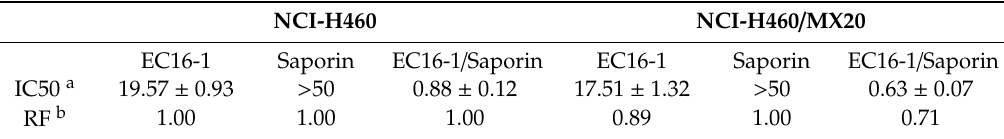
Table 2. E ff ect of EC16-1 / saporin on the cellular proliferation of NCI-H460 and NCI-H460 / MX20 cells. Table 2. Effect of EC16-1/saporin on the cellular proliferation of NCI-H460 and NCI-H460/MX20 cells. NCI-H460